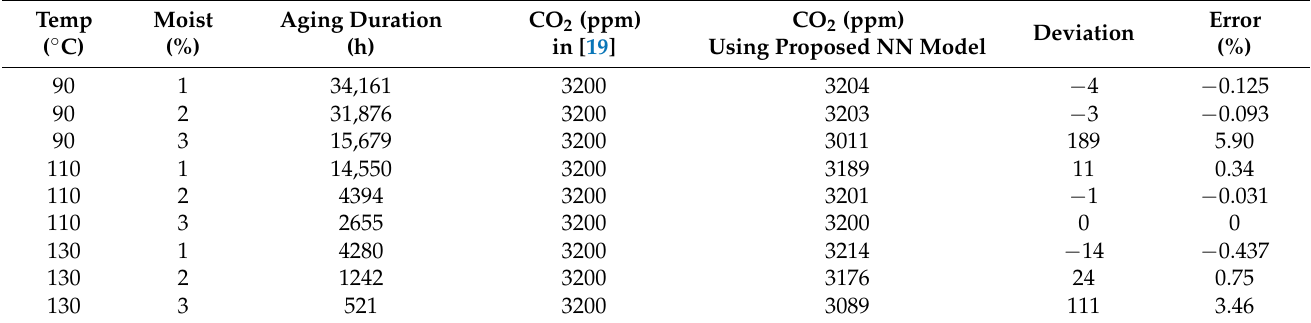
Table 4. Comparison of estimated life using neural network by treating CO 2 as a failure index.